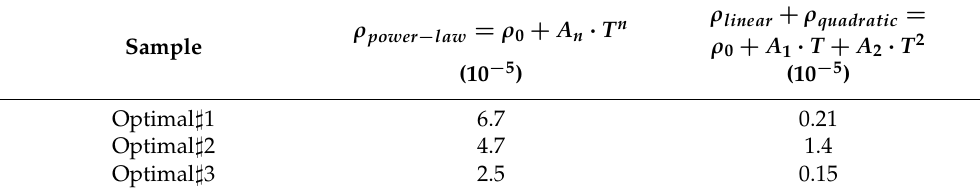
Table 1. Normalized χ 2 values for three selected SLCO samples with electronic doping close to the optimal condition (data refer to samples reported in Figure 2) for the fitting formulas in Equations (1) and (2).